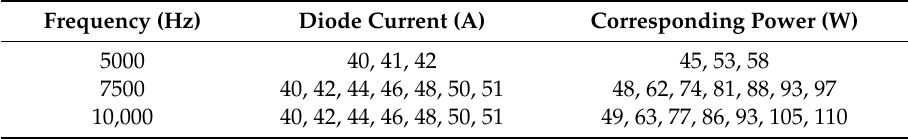
Table 2. Overview of the employed pulsed laser parameter